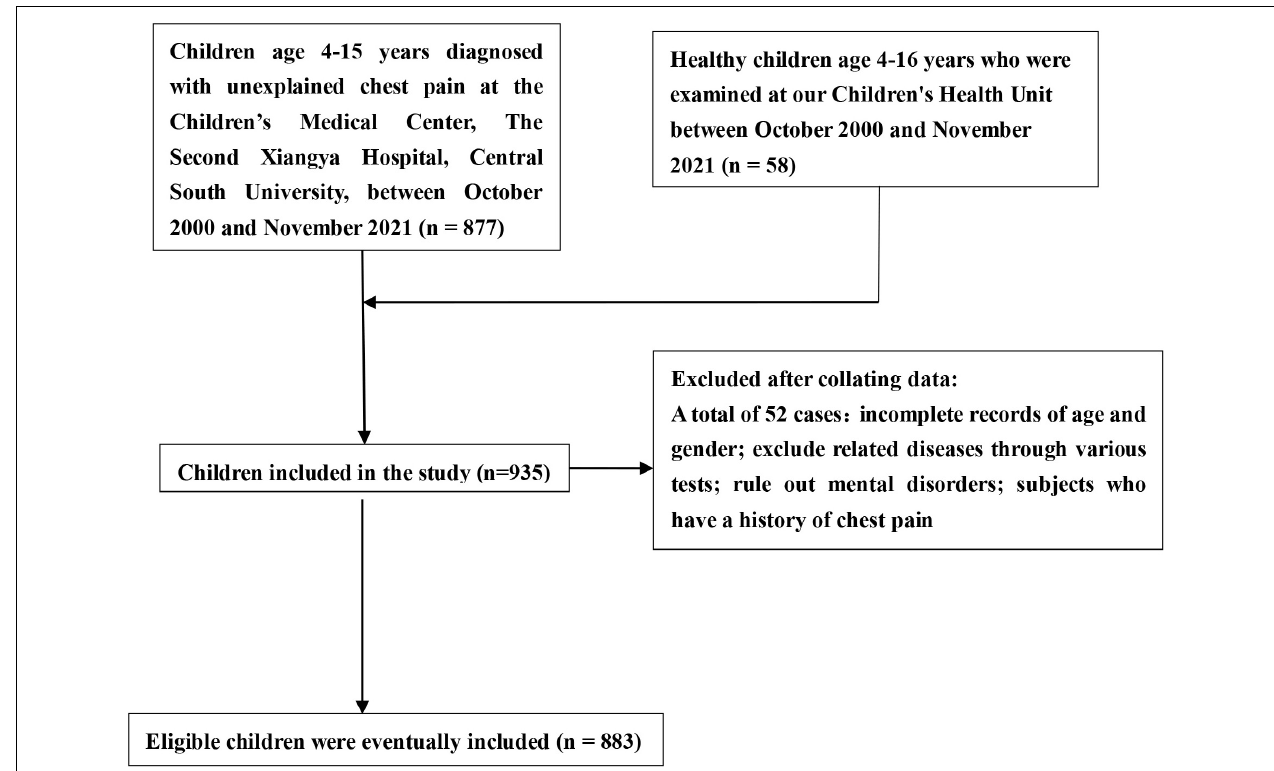
FIGURE 1 | Inclusion and exclusion